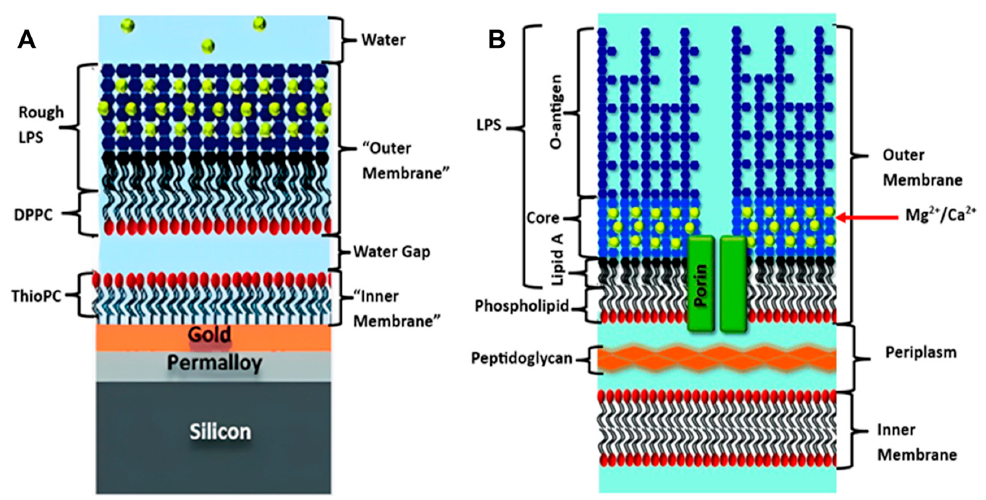
Figure 4. ( A ) Floating model of Gram-negative bacterial membrane, ( B ) Original Bacterial membrane structure. [reproduced with permission from Clifton, et al. [45], copyright 2015 Wiley].